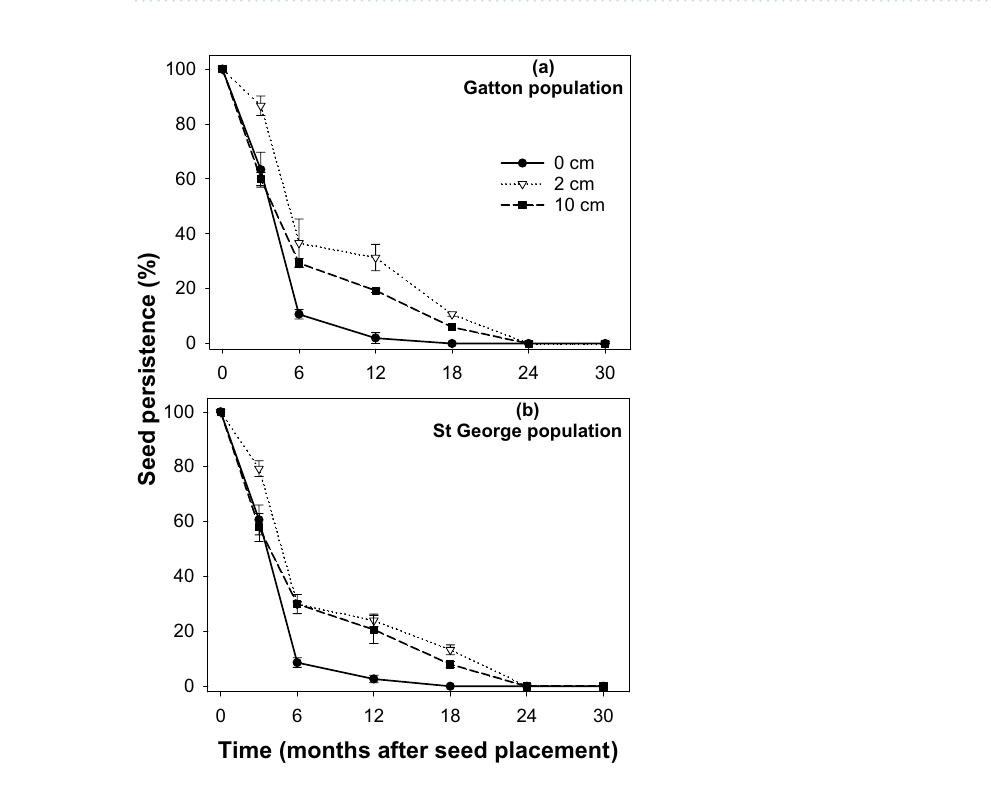
Figure 2. Rainfall at Gatton corresponds to emergence of weeds in trays under a rainfed environment starting from November 2015 to April 2017.